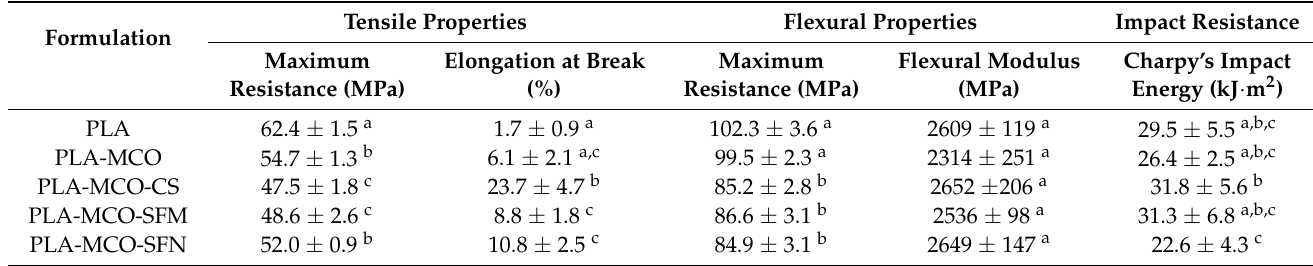
Table 2. Tensile, flexural, and impact resistance properties of samples